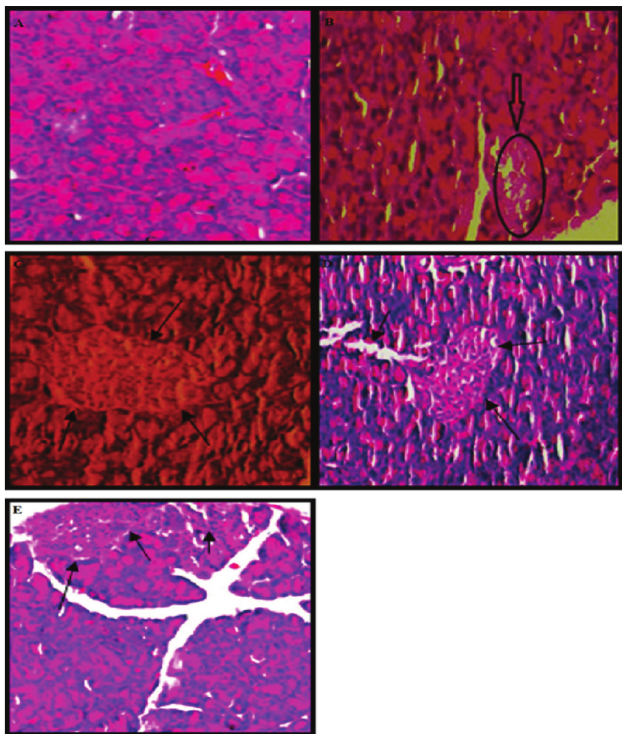
FIGURE 5 - Pancreas of control group showing normal islet cell morphology and architecture. B = pancreas of diabetic control group showing necrotic islet cells in circle with dilated acini and islet shrinkage. C = pancreas of glibenclamide-treated group showing increased islet size and proliferating beta cells (black arrows) and normal pancreatic architecture (bold arrows). D = pancreas of AESO 250 mg/kg treatment group showing improved islet structure with minimal necrosis and relatively proliferating cells. E = pancreas of AESO 500 mg/kg treatment group showing large patches of highly proliferating beta cells with normal pancreatic architecture. Bold arrows show normal cell architecture while black arrows show highly proliferating islet (H & E stain, X20 &